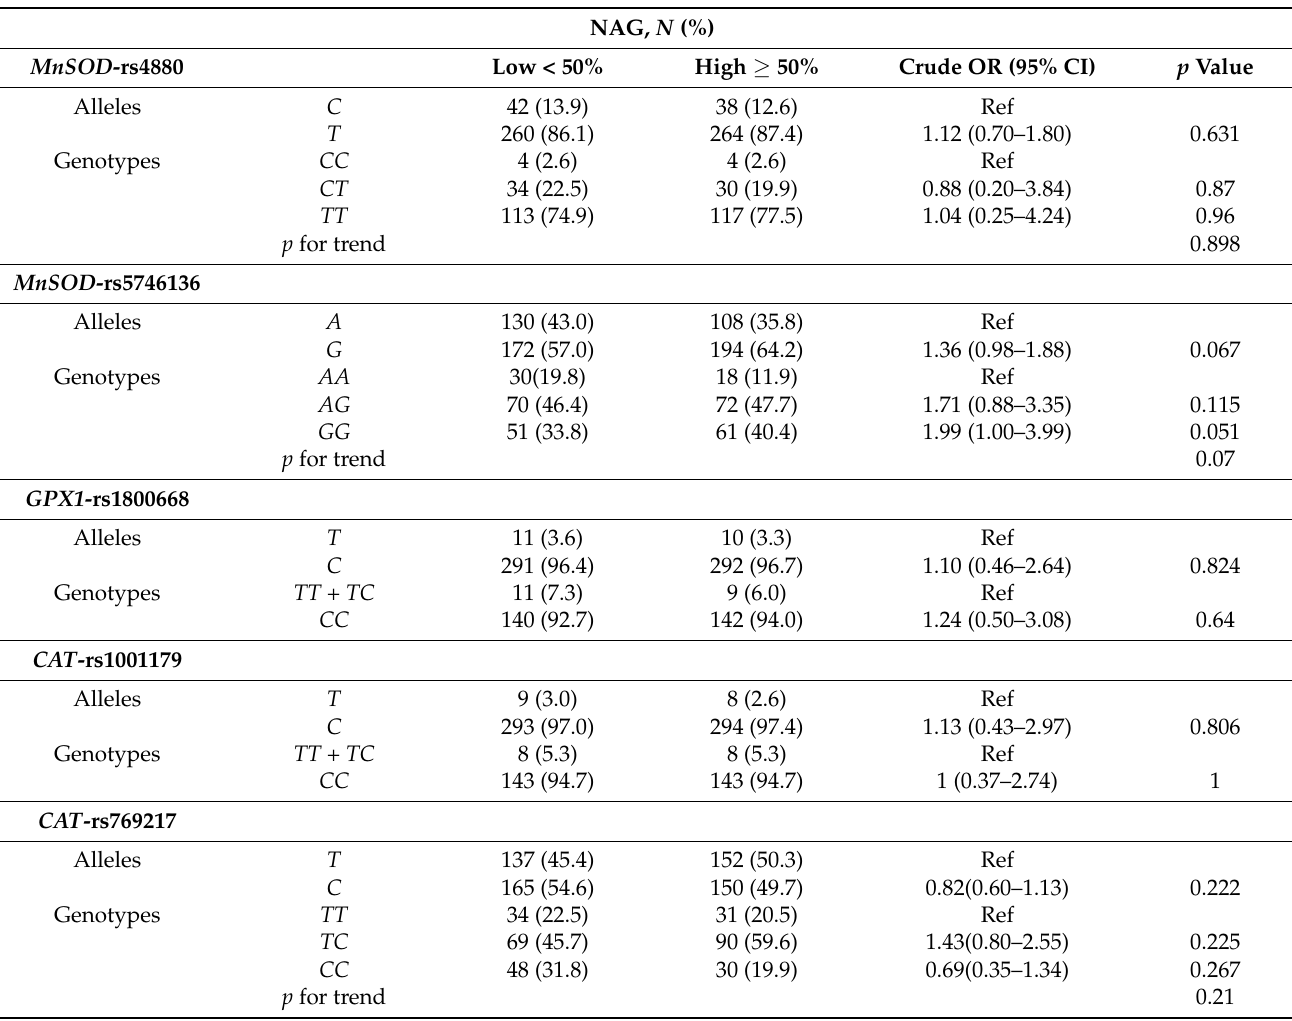
Table 4. Relationships of SNPs of antioxidant enzyme genes with a urinary biomarker of renal tubular injury, NAG, in 302 calcium urolithiasis